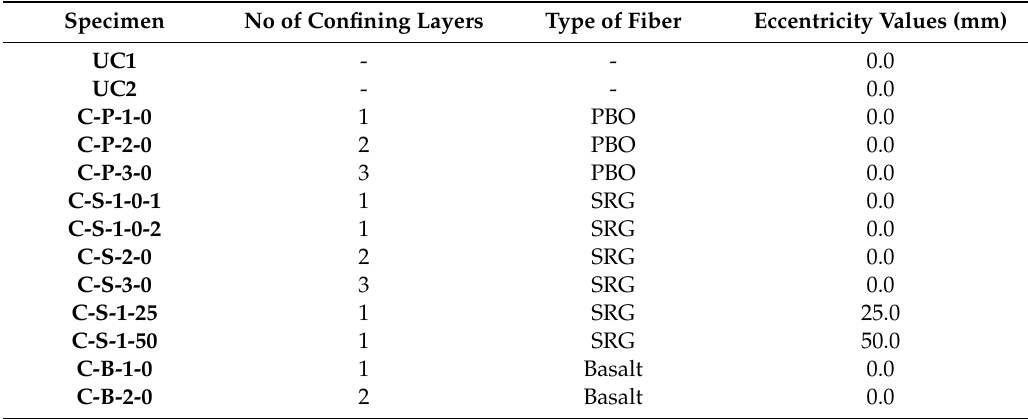
Table 1. Details of tested specimens.